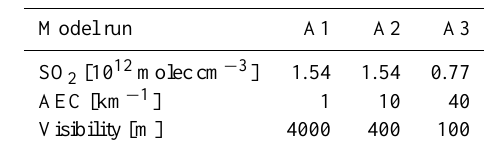
Table 3. SO 2 concentrations, AEC and corresponding visibilities of the plume for different type A model runs. For further details see